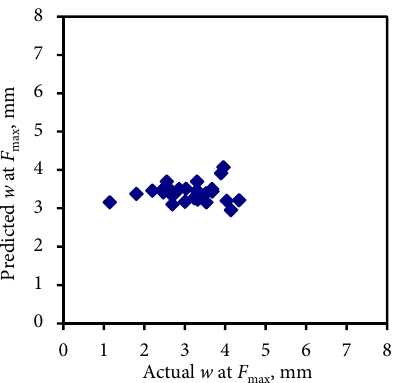
Fig. 8. Prediction of w at F max for independent query test dataset